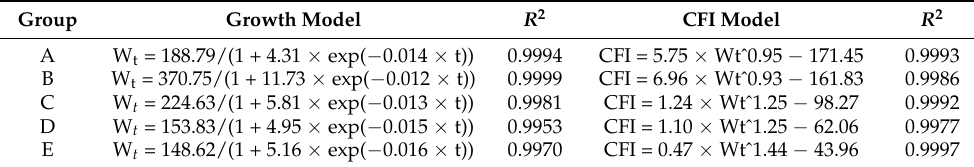
Table 3. Details of growth and CFI models.